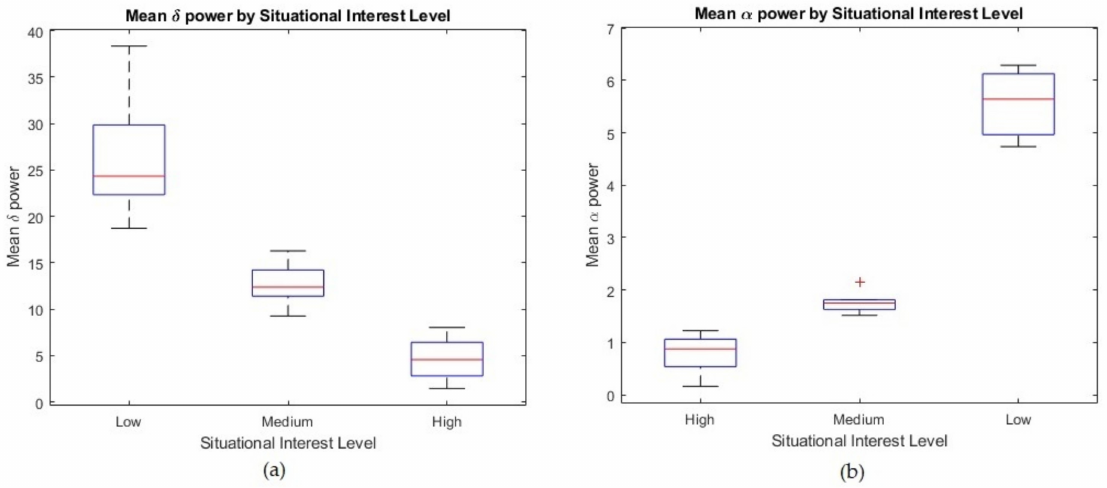
Figure 8. Box plot of mean power for ( a ) delta ( b ) alpha for the high, medium, and low SI stu- dent groups.